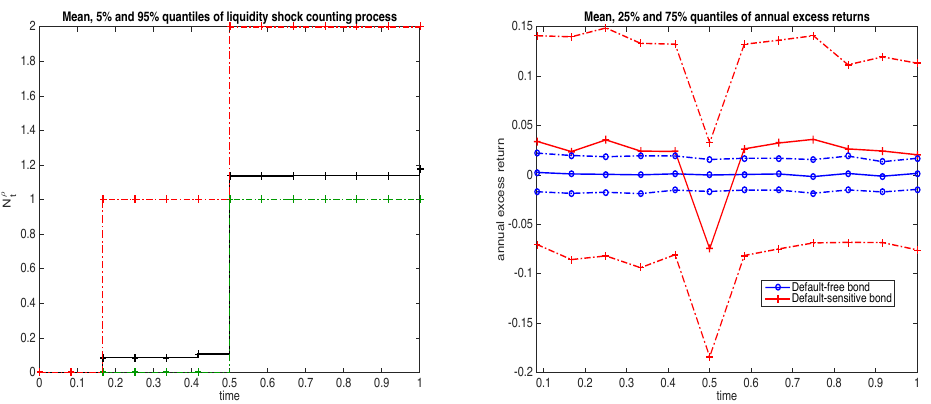
Figure 1. Empirical mean: 25% and 75% quantiles of sampled paths of N ρ ( left ) and of sampled paths of the risky assets’ annual excess return rates R e ,1 period, i.e., at time t 1 , . . . , t m